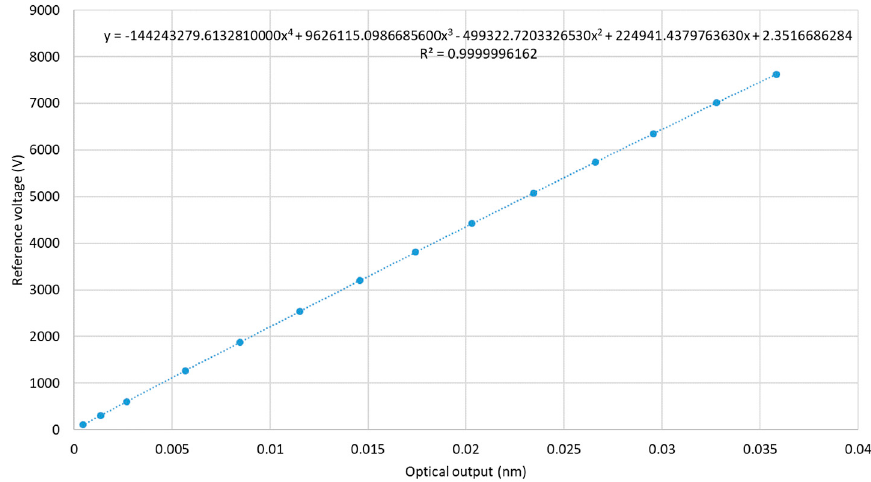
Figure 26. MV PVT calibration curve.